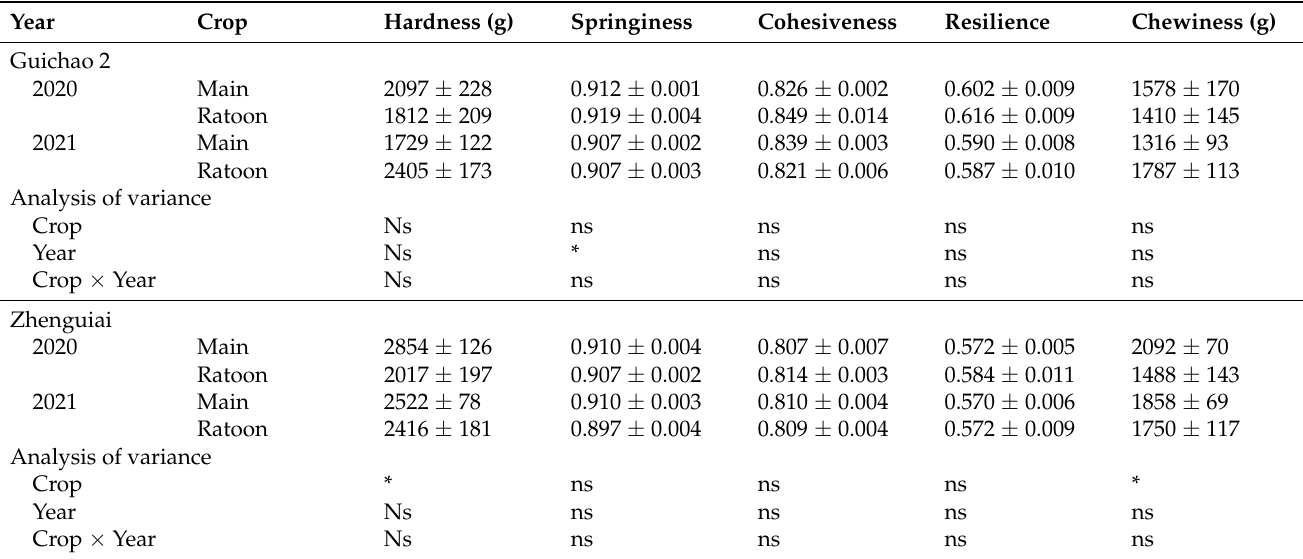
Table 3. Texture profiles of cooked noodles processed from rice grains of main and ratoon crops of two cultivars, Guichao 2 and Zhenguiai, grown in 2020 and 2021.